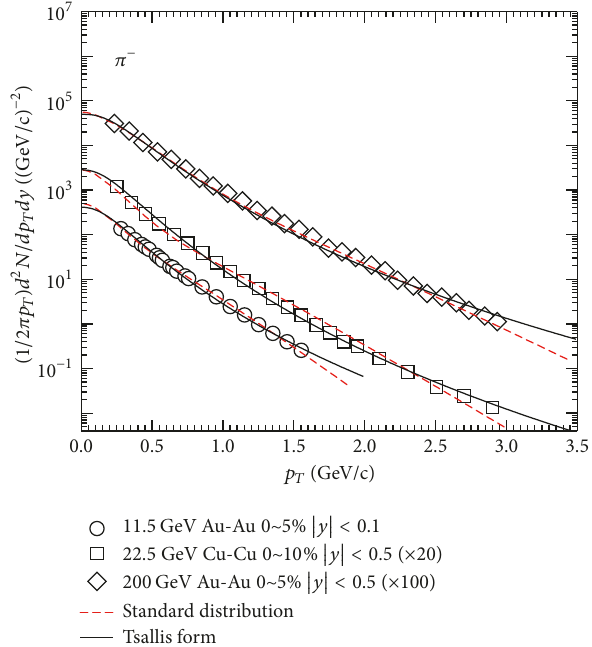
Figure 3: Same as Figure 1, but for central Au-Au collisions at = 11.5 GeV (circles), central Cu-Cu collisions at √ 𝑠 √ 𝑠 𝑁𝑁 22.5 GeV (squares), and central Au-Au collisions at √𝑠 200 GeV (rhombuses). The symbols represent the experimental data of the STAR Collaboration with the statistical and systematic errors added in quadrature (circles) [42], and the PHENIX Collaborations with statistical errors only (squares [43] and rhombuses [27]).